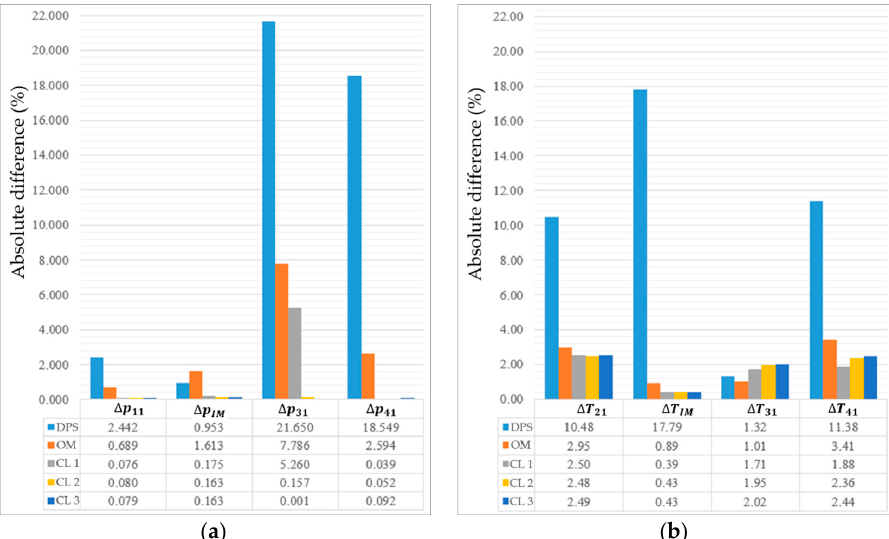
Figure 8. Comparison of the absolute differences between the results of simulation and measurement for pressure and temperature (Table 2) at the 3800 rpm full-load steady-state operating point applying three different approaches for CBPs determination in the applied ICESM. DPS represents simulation results achieved with the default CBPs available during the ICESM model set-up, and OM results achieved by using a one-step optimization method and CL one to three simulation results obtained by the HCM employed in three CLs: ( a ) Absolute differences of the pressures p 11 , p IM , p 31 and p 41 ; ( b ) Absolute differences of the temperatures T 21 , T IM , T 31 and T 41